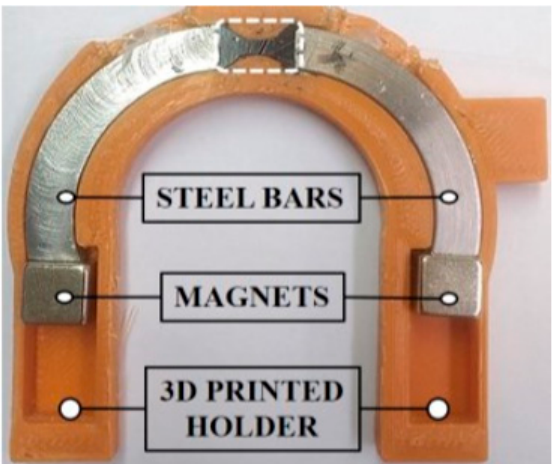
Figure 12. Optical fiber current sensor based on 1.5 g hyperboloid magnetostrictive composite material.